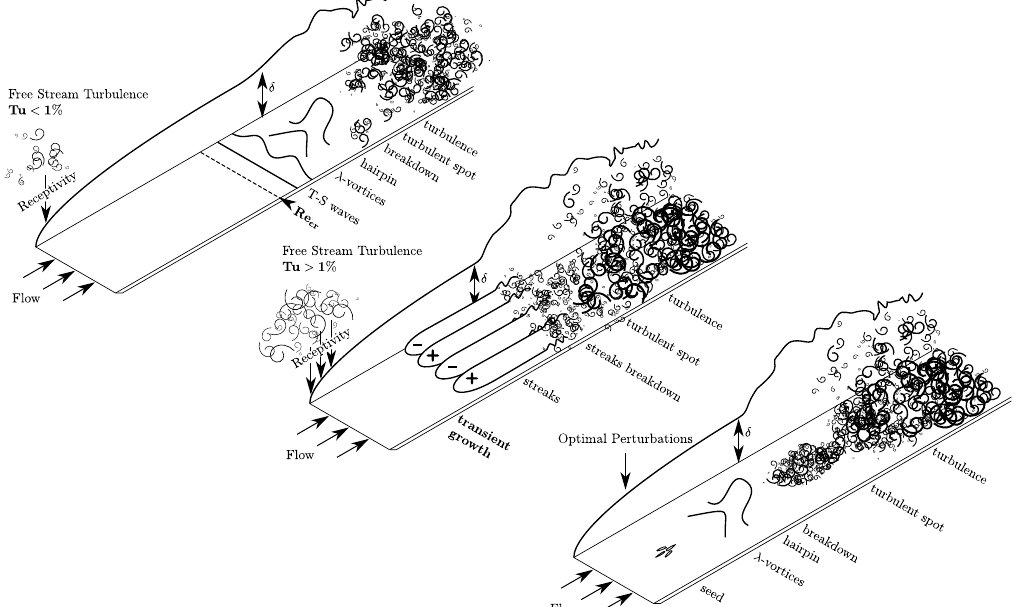
Figure 1. Sketch of a transitional flow over a flat plate. Depending onto the turbulence intensity ( Tu ) in the external free-stream, the path to transition can follow different routes: ( top ) a low-intensity, K-type like transition scenario, with the successive onset of TS-waves, λ and hairpin vortices; ( middle ) a bypass transition scenario, triggered by a transient energy growth of the perturbations leading to the onset of streamwise velocity modulation and its successive break- down; or ( bottom ) a nonlinear transition scenario triggered by localized high-amplitude perturbations generating λ hairpin